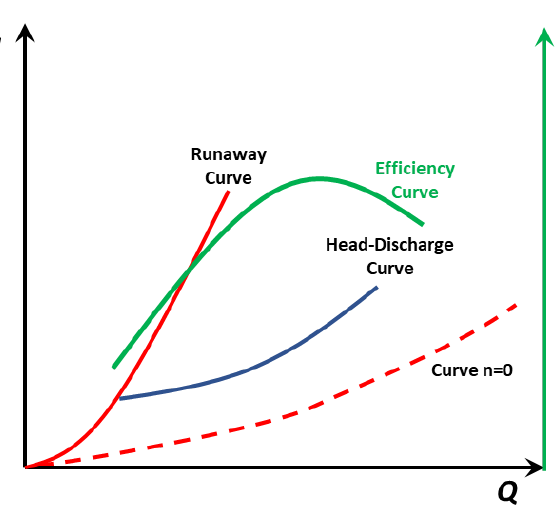
Figure 2. Characteristics curves in a PAT.